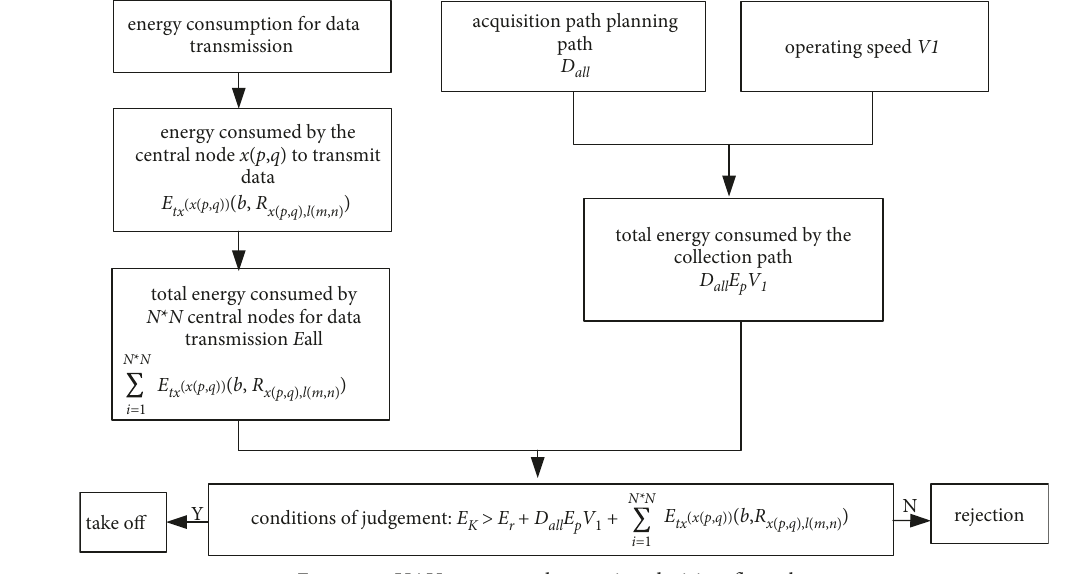
Figure 7: UAV energy early warning decision flow chart. Table 2: LoRa terminal node communication performance test